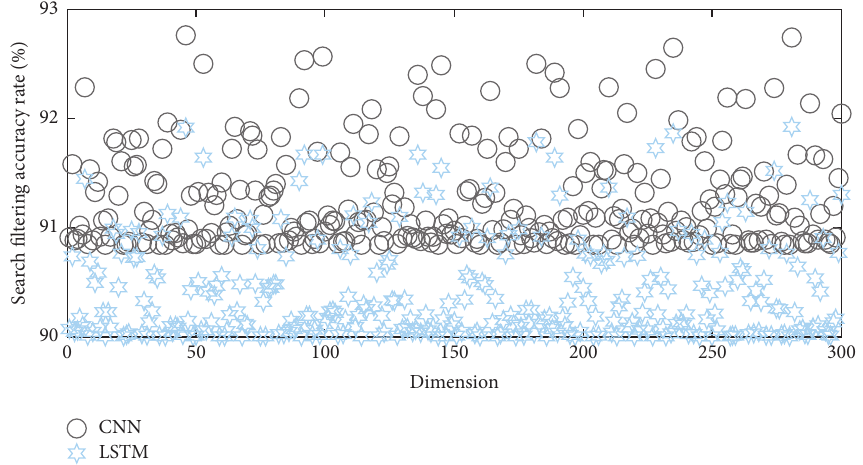
Figure 8: The accuracy of search filtering at the detection